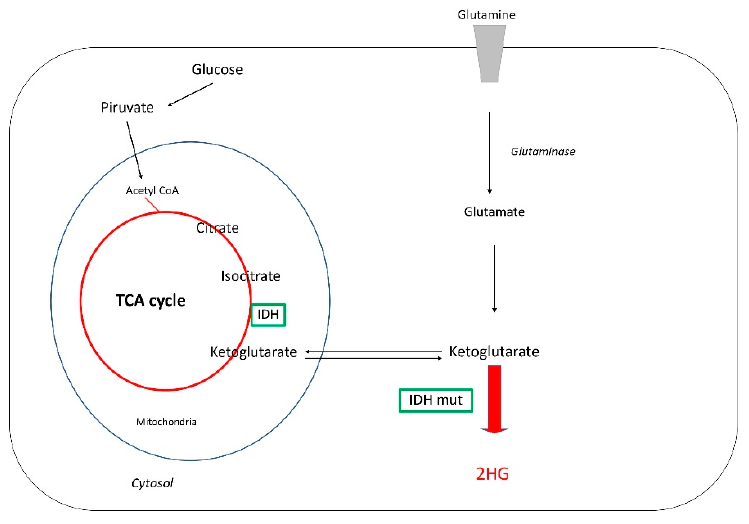
Figure 1. Glutamine and D2-Hydroxyglutarate metabolism in IDH mutant. Other Amino Acids: Adenosine and